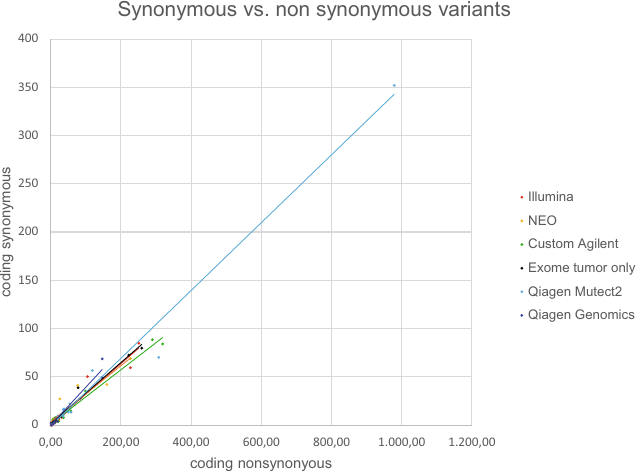
Figure 1. TMB values in mutations per MB of only coding non-synonymous (x-axis) and synonymous (y-axis) for bioinformatic pipelines that allowed for this differentiation. Panels: Illumina—TSO500; NEO—NEOplus v2 RUO TMB (NEO New Oncology); Custom Agilent custom—custom panel Agilent SureSelect XT HS; Exome tumor only—WES Agilent SureSelect XT HS Human All Exon v6 panel; Qiagen Mutect2—Qiagen TMB v3.0 (Qiagen) analyzed with Mutect2 in-house pipeline; Qiagen Genomics—Qiagen TMB v3.0 (Qiagen) analyzed with Qiagen Genomics Workbench 12.0.2.; Oncomine Tumor Mutation Load assay (Thermo Fisher Scientific) did not allow for differentiation of synonymous and non-synonymous variants.